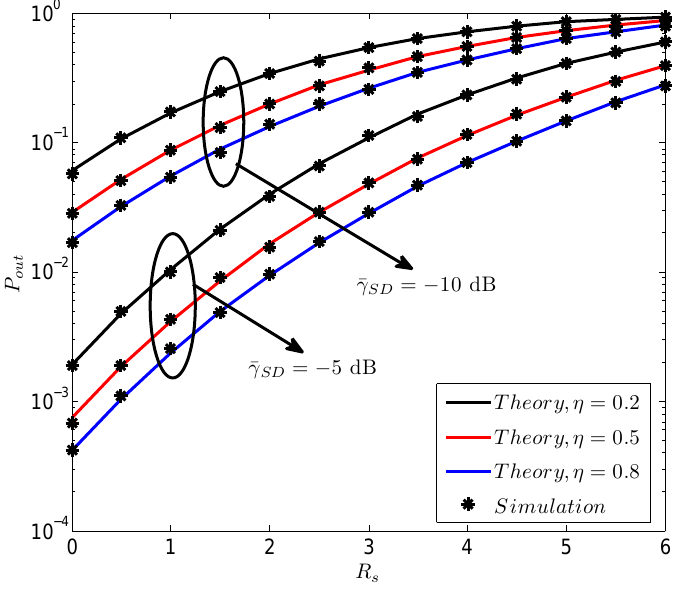
Figure 3. P out vs. R s with different ¯ γ SD and η . γ S = 30 dB, ¯ γ SE =